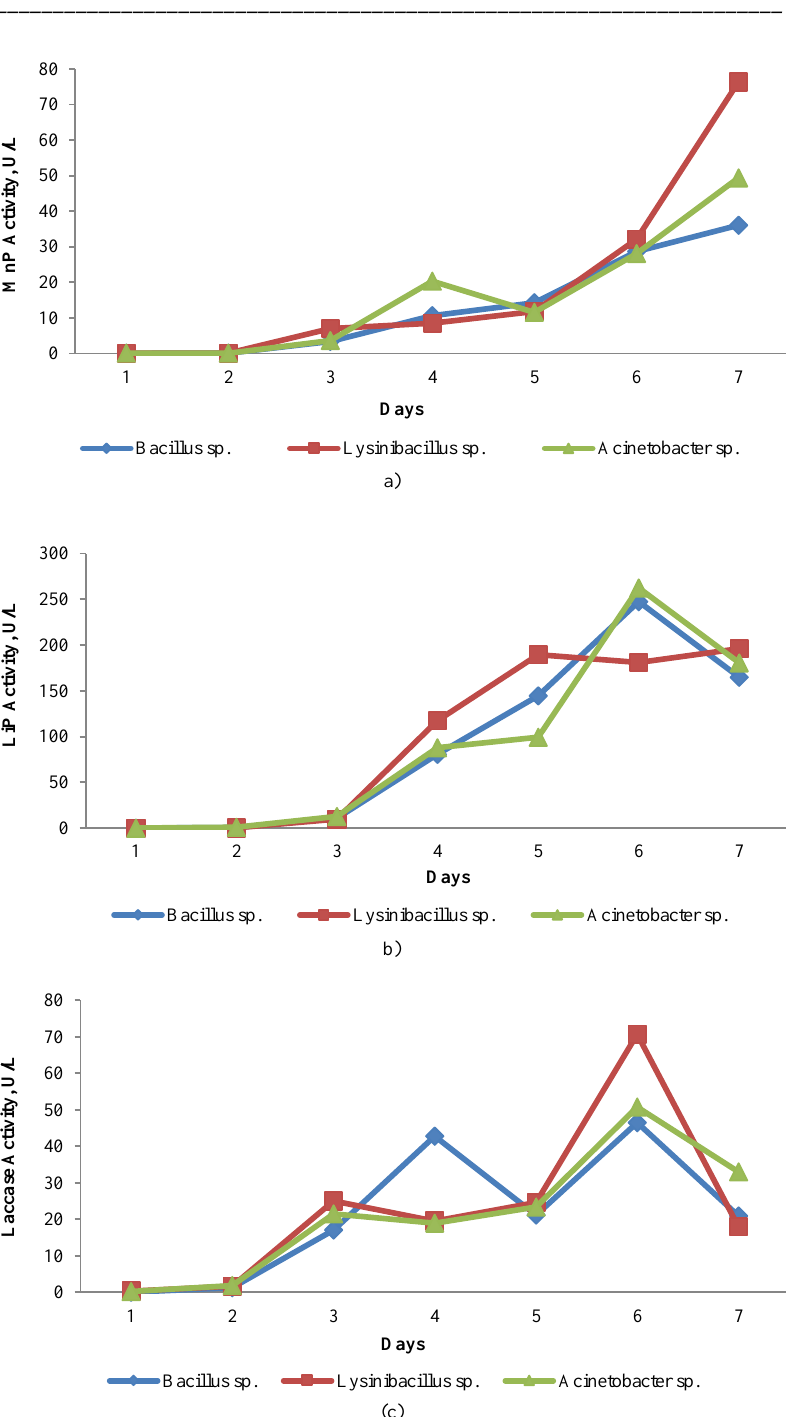
Fig. 2. Enzyme activities of a) MnP; b) LiP; c) Laccase during degradation of kraft lignin in submerged fermentation